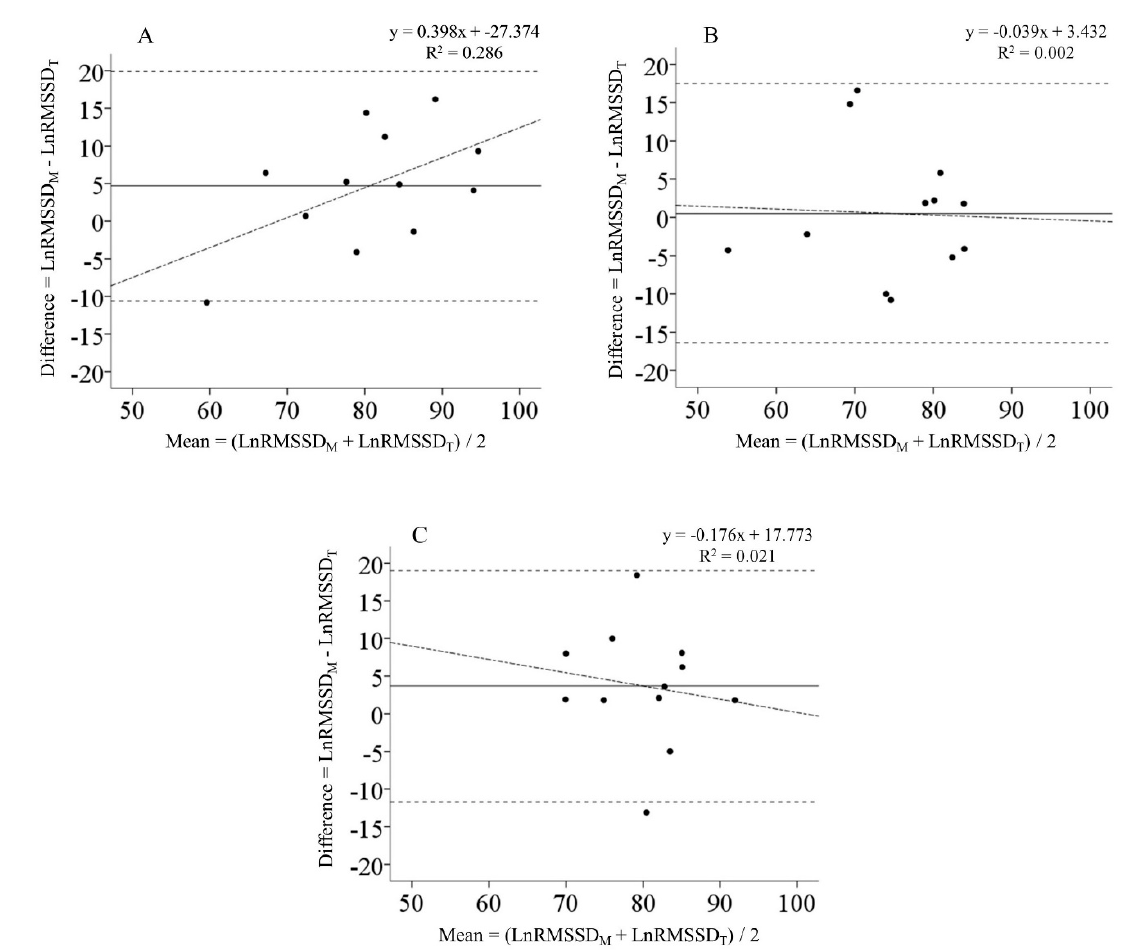
Figure 2. Bland–Altman plots comparing heart rate variability recorded upon waking (LnRMSSD M ) and heart rate variability recorded upon arriving at the training facility (LnRMSSD T ) during the ( A ) baseline, ( B ) post-overload, and ( C ) post-taper test sessions. The solid lines represent the mean bias while the horizontal dashed lines represent the 95% limits of agreement. The dashed-dotted regression lines represent the trend between the differences and means.